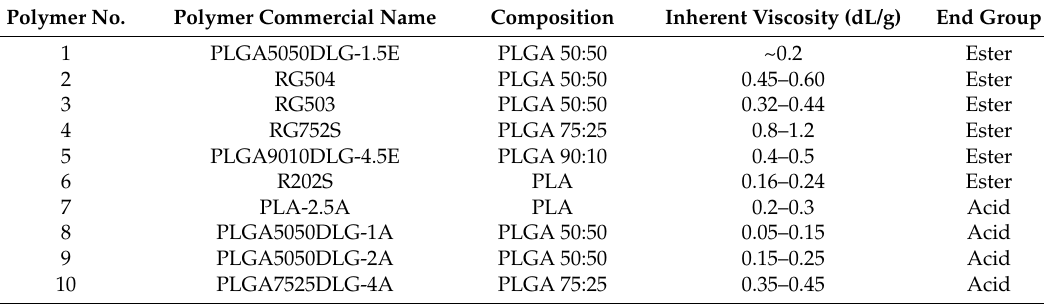
Table 1. Physicochemical properties of the PLGA and PLA